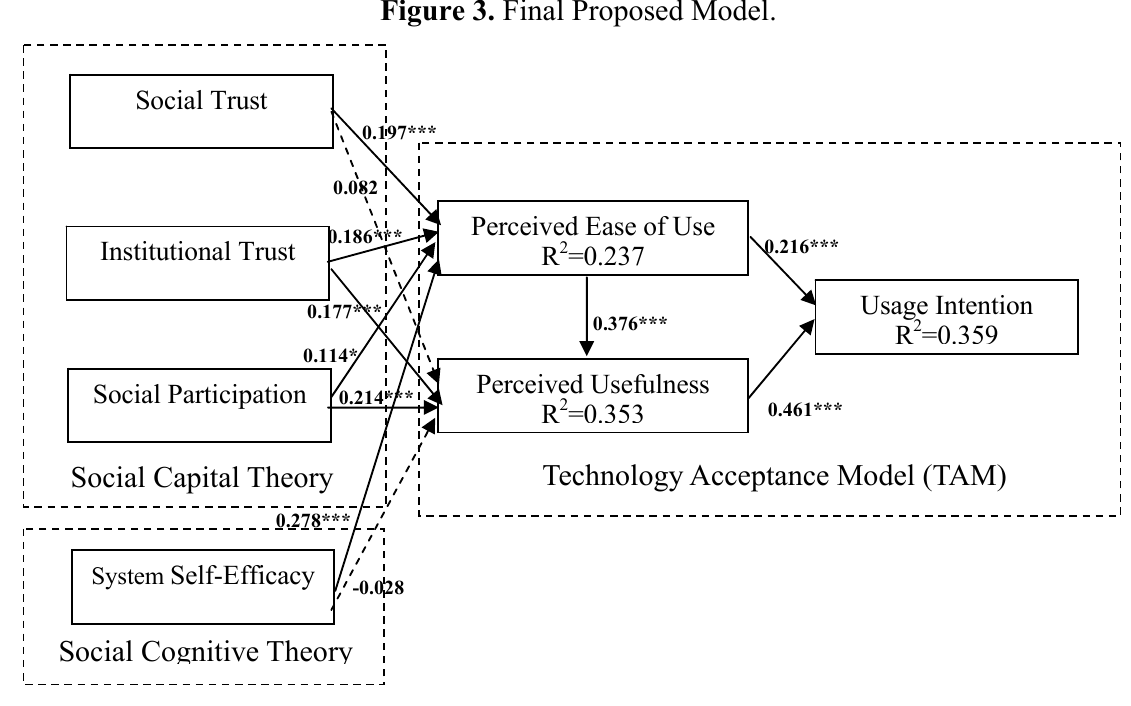
Figure 3. Final Proposed Model.